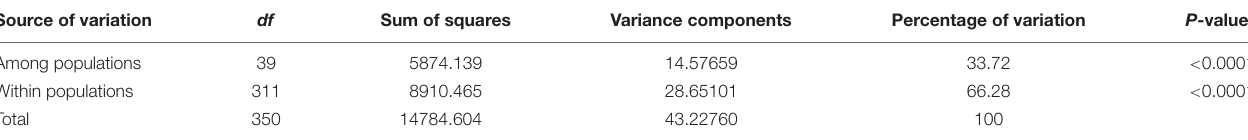
TABLE 3 | Partition of genetic